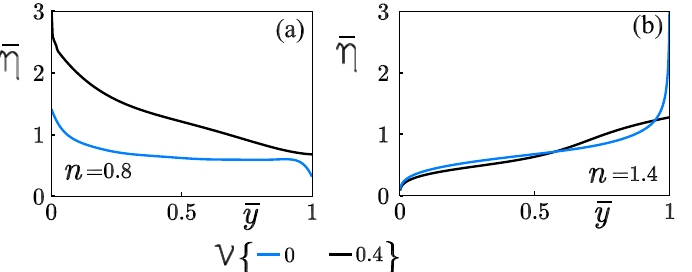
Figure 5. Variation of dynamic viscosity across the microchannel with and without the influence of steric effects. ( a ) Shear-thinning and ( b ) shear-thickening